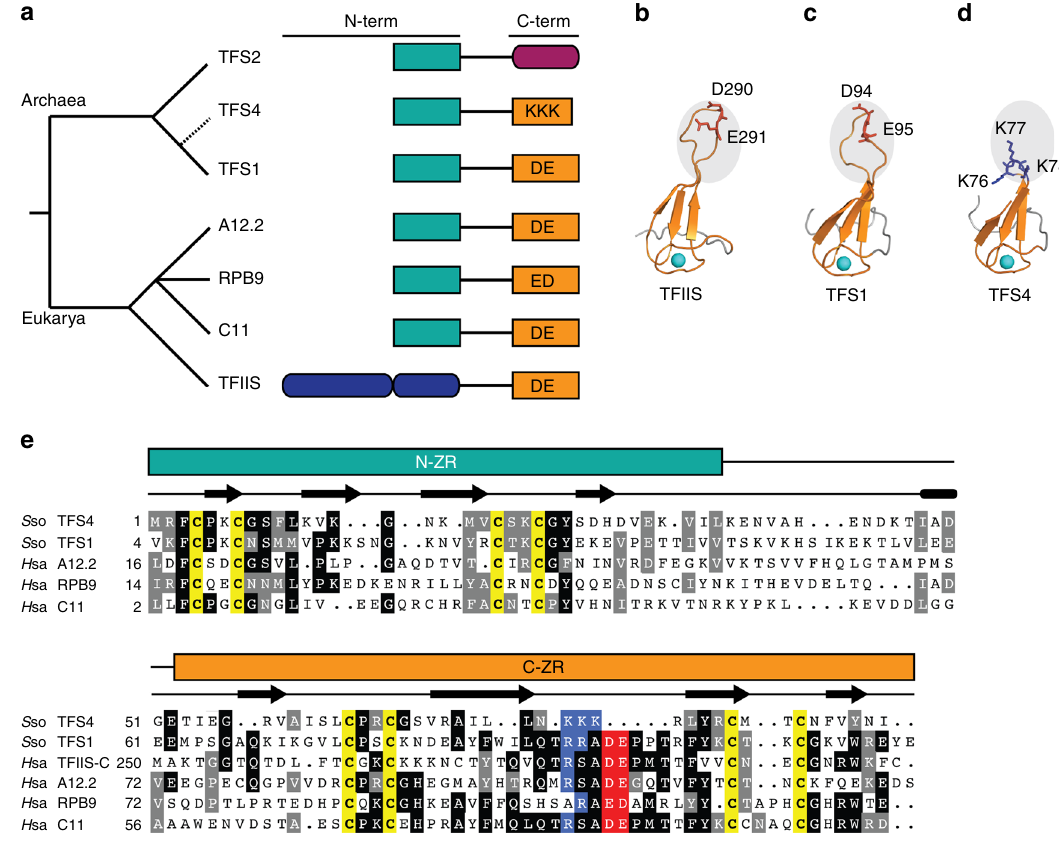
Fig. 1 Evolutionary conservation of TFIIS-like proteins. a Phylogenetic distribution and domain conservation of TFS-related proteins in archaea and eukaryotes. Gene duplication events speci fi c to the Sulfolobales order are shown as dashed lines. Zinc ribbon and α -helical domains as symbolized by rectangles and ellipses, respectively. b – d Structural homology between yeast TFIIS ( b ), Sso TFS1 ( c ) and Sso TFS4 C-ZR ( d ). Structural models of the C-ZR domains of TFS1 ( C -score: 0.63; TM-score: 0.80 ± 0.09) and TFS4 ( C -score: − 0.03; TM-score: 0.71 ± 0.12) were prepared using PHYRE 2 56 . The two carboxylate residues (TFIIS and TFS1) and the lysine residues (TFS4) are highlighted as stick representation in red and blue, respectively. Zn 2+ ions are shown as cyan spheres. e Sequence alignment of of Sulfolobus solfataricus ( Sso ) TFS4 (AAK42105.1), Sso TFS1 (AAK40629.1), Homo sapiens ( Hsa ) RPB9 (P36954.1), Hsa A12.2 (Q9P1U0.1), Hsa C11 (AAD31424.1), Hsa TFIIS C-ZR (AAH72460.1). Secondary structure prediction of Sso TFS1 is shown above